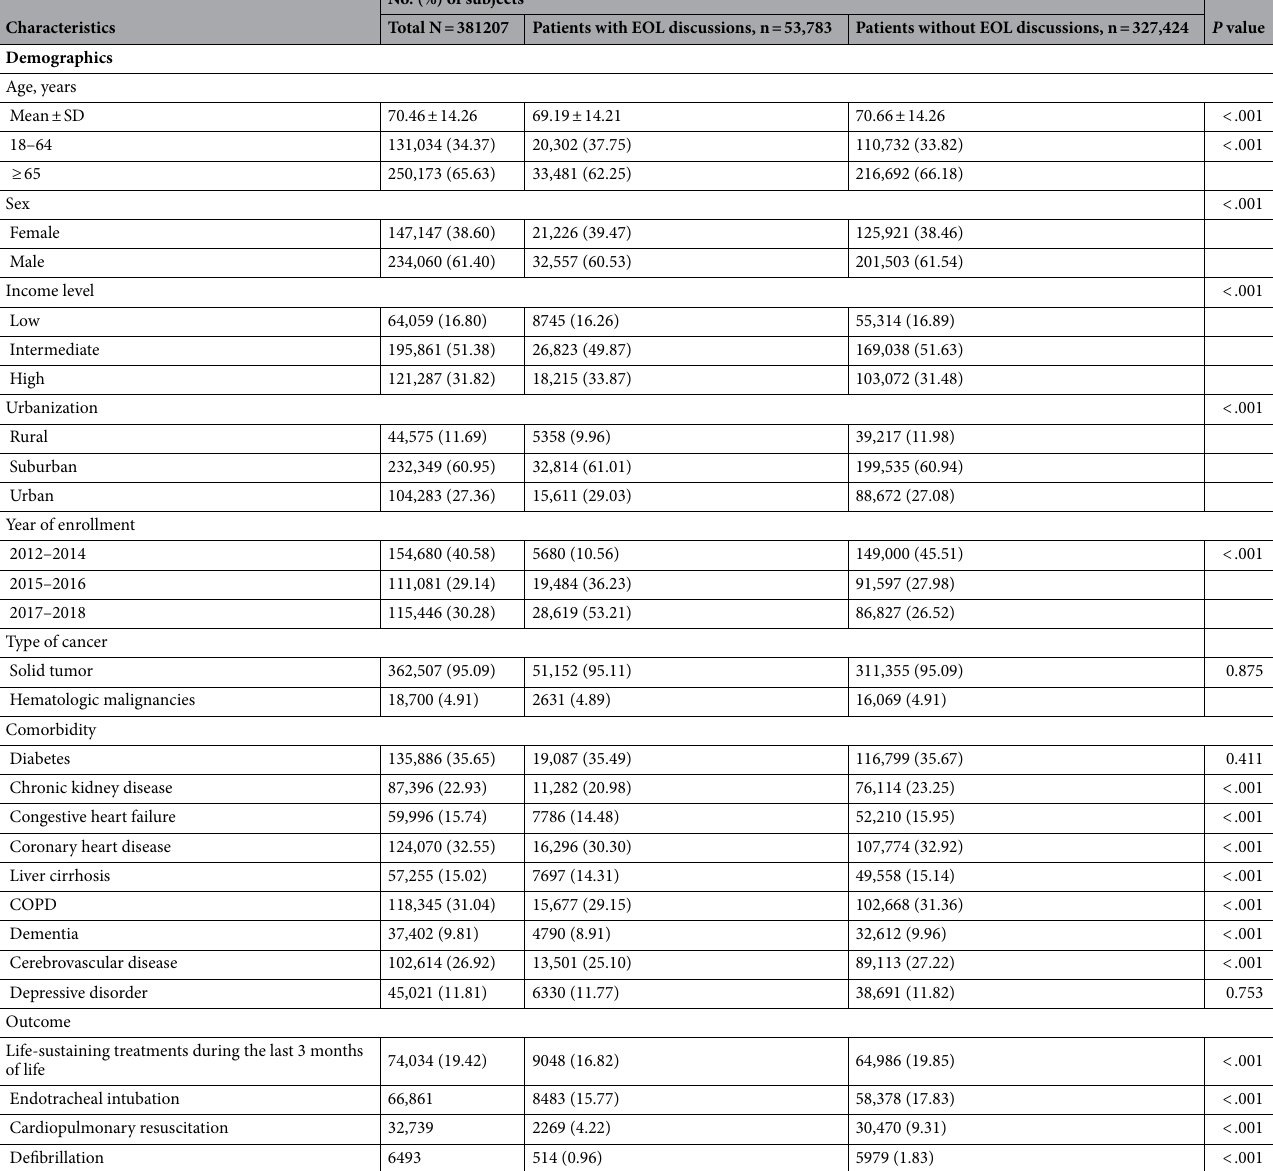
Table 1. Characteristics of deceased cancer patients by end-of-life discussions. EOL, end-of-life; SD, standard deviation; COPD, chronic obstructive pulmonary disease. a Unless stated